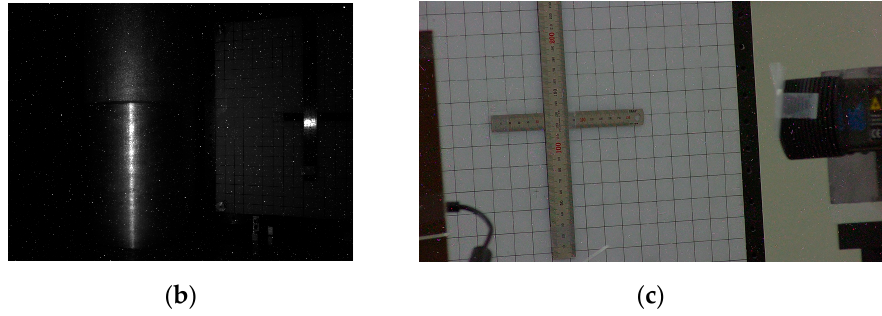
Figure 6. Experimental Data at 5H56M: ( a ) 3D Point Cloud; ( b ) Image of Camera; ( c ) Image of IP Camera.